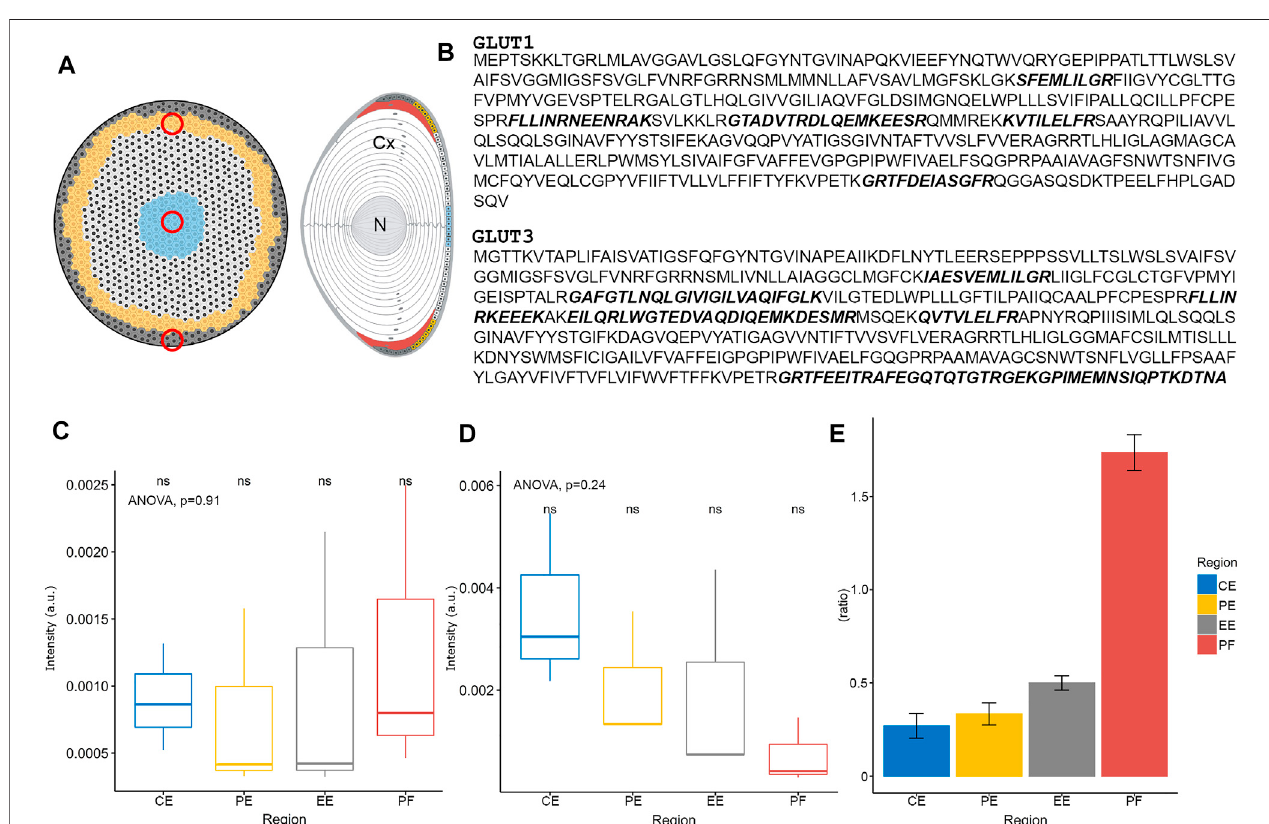
FIGURE4| SpatialproteomicsofGLUTsinthelensepitheliumandoutercortex. (A) Schematicdiagramofbovinelensepithelialcell fl atmount(left)andaxialsection (right) indicating regions (red circles) where tissue was collected for subsequent proteomic analysis. Cx = cortex, N = nucleus. (B) Amino acid sequences of bovine GLUT1 and GLUT3. Peptides detected by proteomic analysis are indicated in bold, italic, and represent a combination of some 11 and 16 peptide fragments collected from all tissue regions for GLUT1 and GLUT3, respectively. (C) Relative quantitation of GLUT1 protein levels in the different lens epithelium and outer fi bre cell regions, normalised to vimentin. (D) Relative quantitation of GLUT3 protein levels in the different lens epithelium and outer fi bre cell regions, normalised to vimentin. (E) GLUT1:GLUT3 ratio in different bovine lens tissue regions. CE = central epithelium ( blue ), PE = peripheral epithelium ( yellow ), EE = equatorial epithelium ( grey ), PF = peripheral fi bre cells ( red ). ns = not statistically signi fi cant as tested by